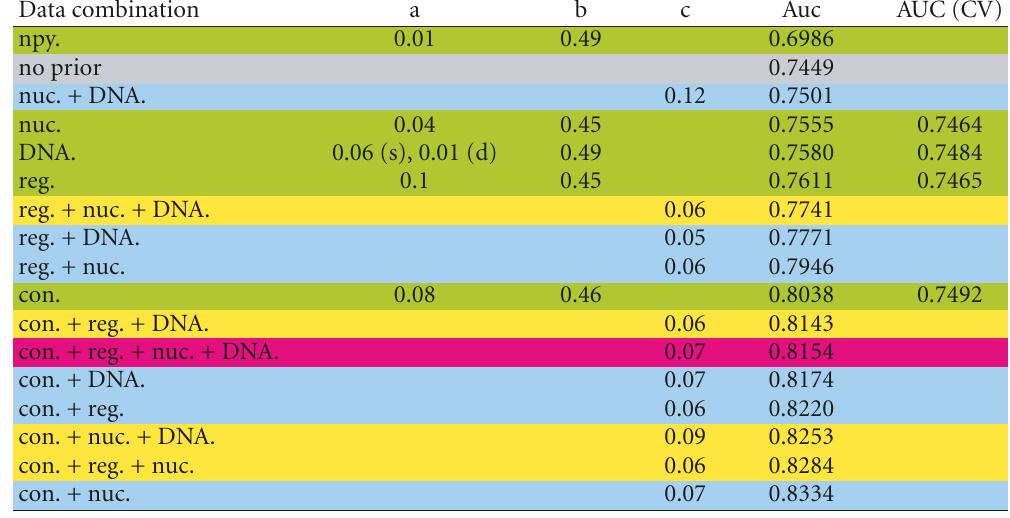
Table 1: AUC scores and scaling parameters for all data sources and their combinations. Data source combinations from 0 to 4 information sources are colored grey, green, blue, yellow, and magenta, respectively. “a” and “b” are the multiplicative factor and bias term, respectively, for scaling each additional data source, and “c” is the scaling parameter used for combining multiple information sources into the TF target gene prediction framework. All the parameters shown here are selected with respect to the largest AUC